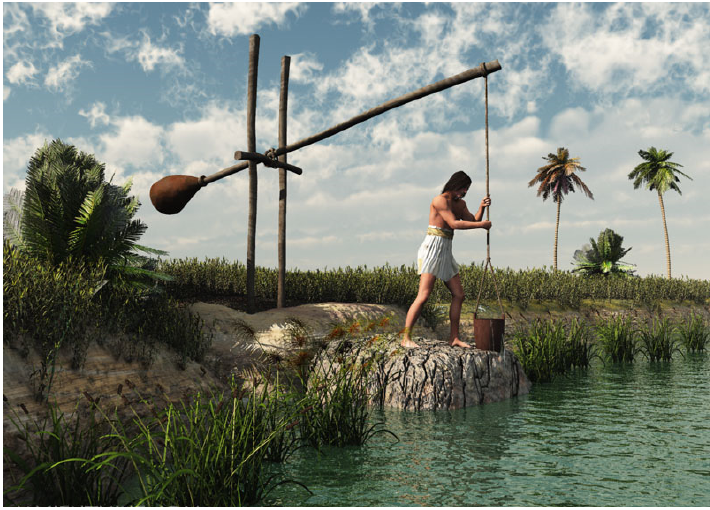
Figure 1. Shaduf used to raise water above the level of Nile for irrigation purposes in Egypt